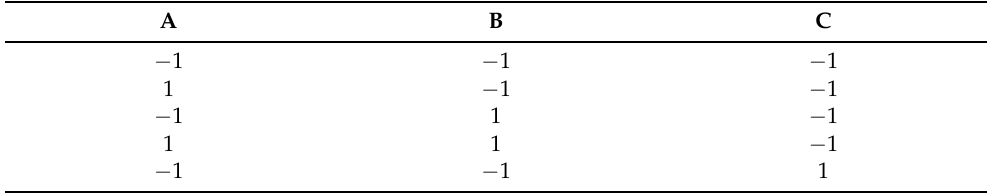
Table A1. Central Composite design scheme. Factors coded as laccase concentration (A), temperature (B), adsorption time